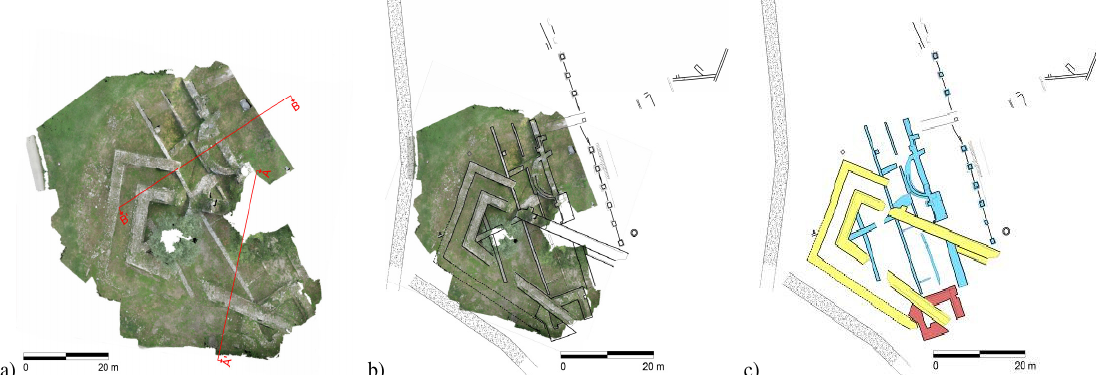
Figure 10. The orthoimage produced from the UAV images with highlighted (AA’, BB’) the produced archaeological sections (a). The site plan created integrating the orthoimage and the topographic survey (b). The three different construction phases highlighted on the map (c).